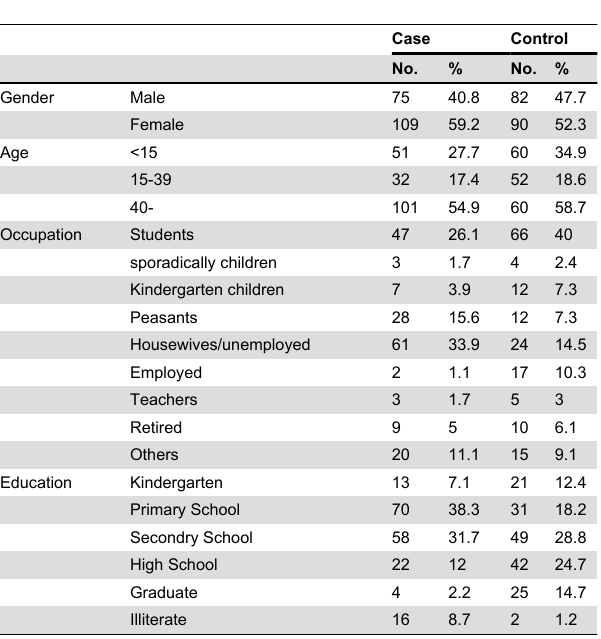
Table 1. Major demographic characteristics of 184 HCV- infected cases and 172